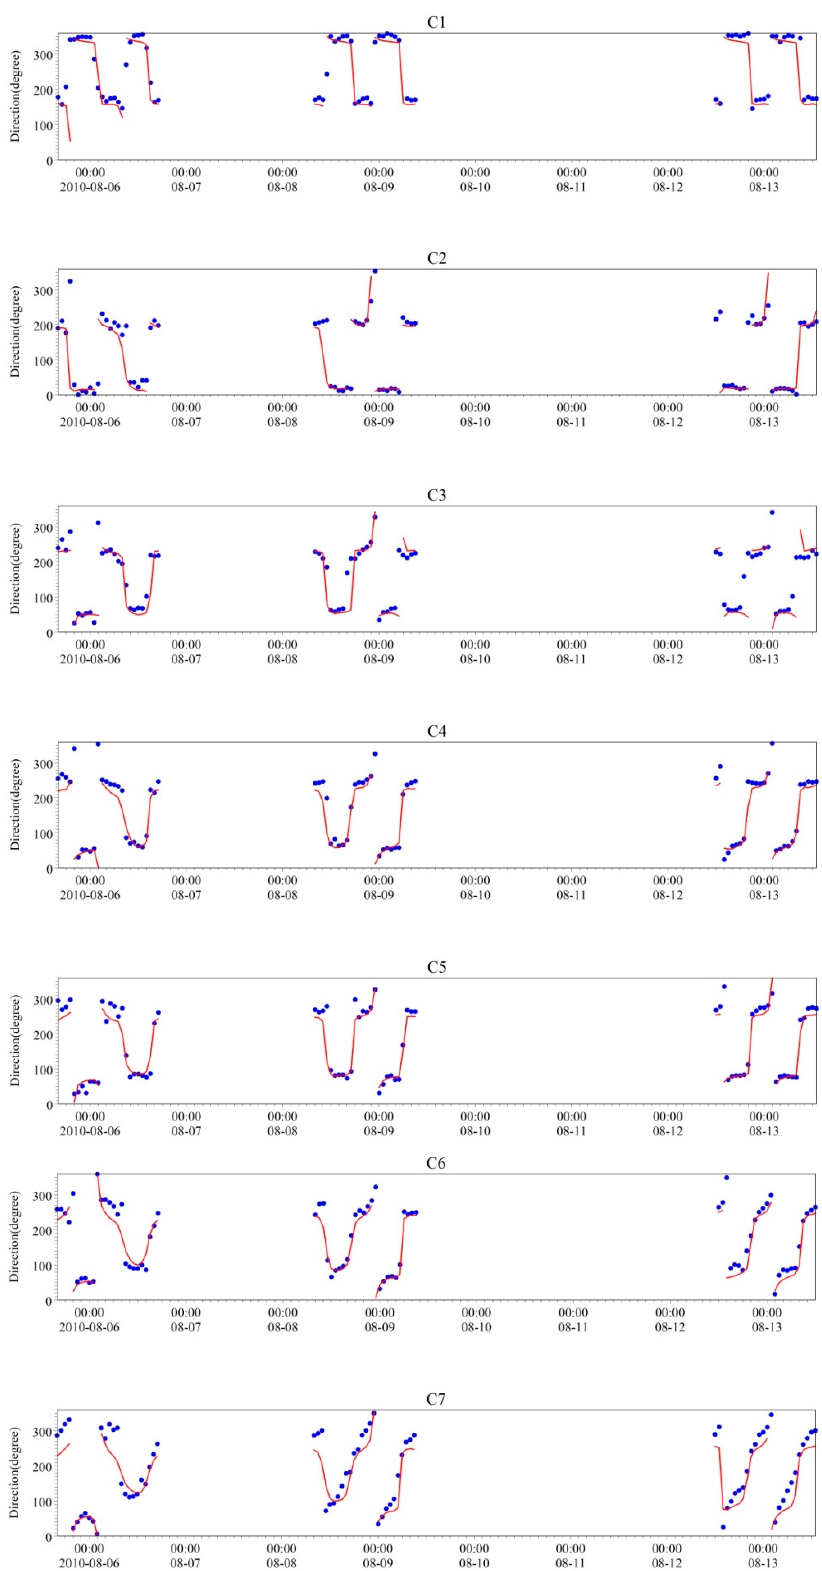
Figure 5. Tidal current velocity validation results ( signify the measured values; signify the simulated values).